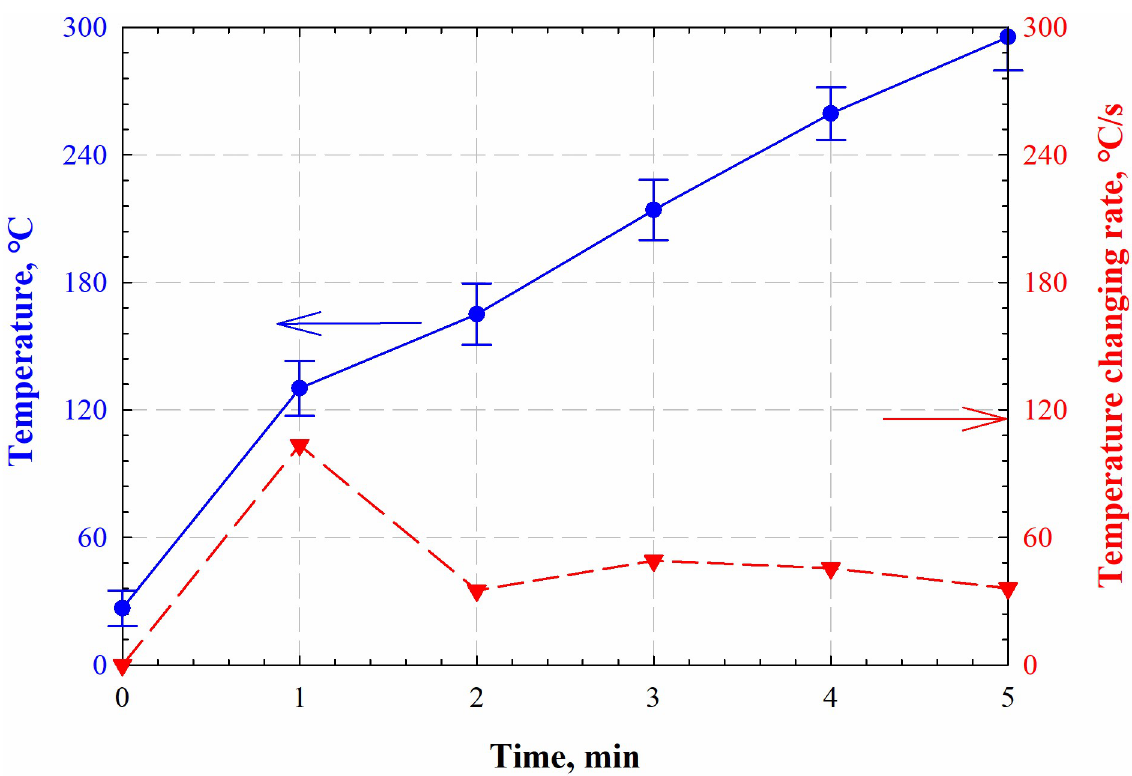
Fig 4. Temperature profiles and temperature-changing rates of shale samples at different electromagnetic radiation